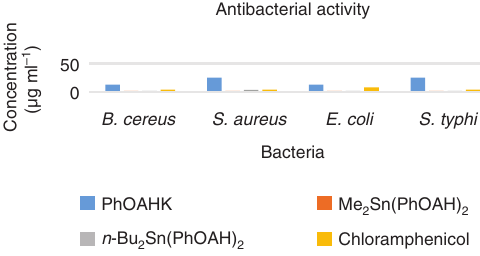
Figure 4: In vitro antibacterial spectrum.